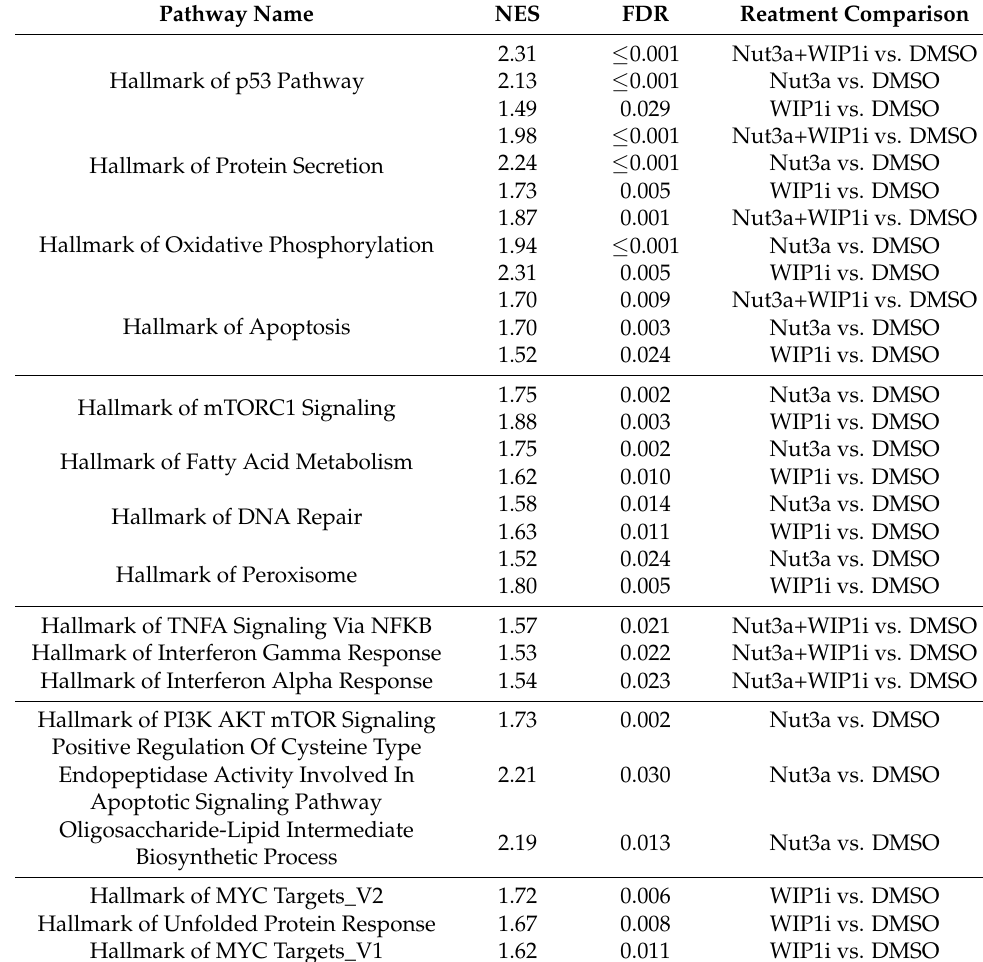
Table 2. Most significant enriched pathways in MV-4-11 cells upon drug